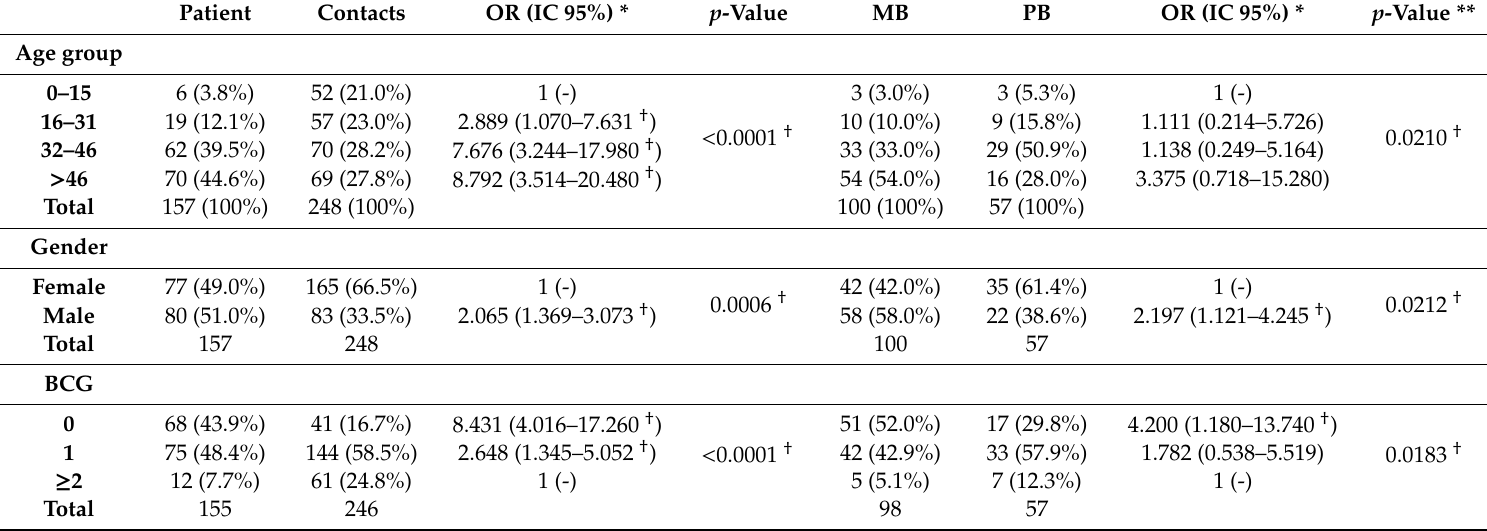
Table 1. Characterization of groups regarding age, gender, and doses of BCG